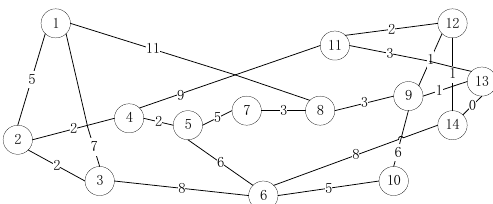
Figure 9. NSFNET topology with 14 nodes, which is the network topologies used in simulation.